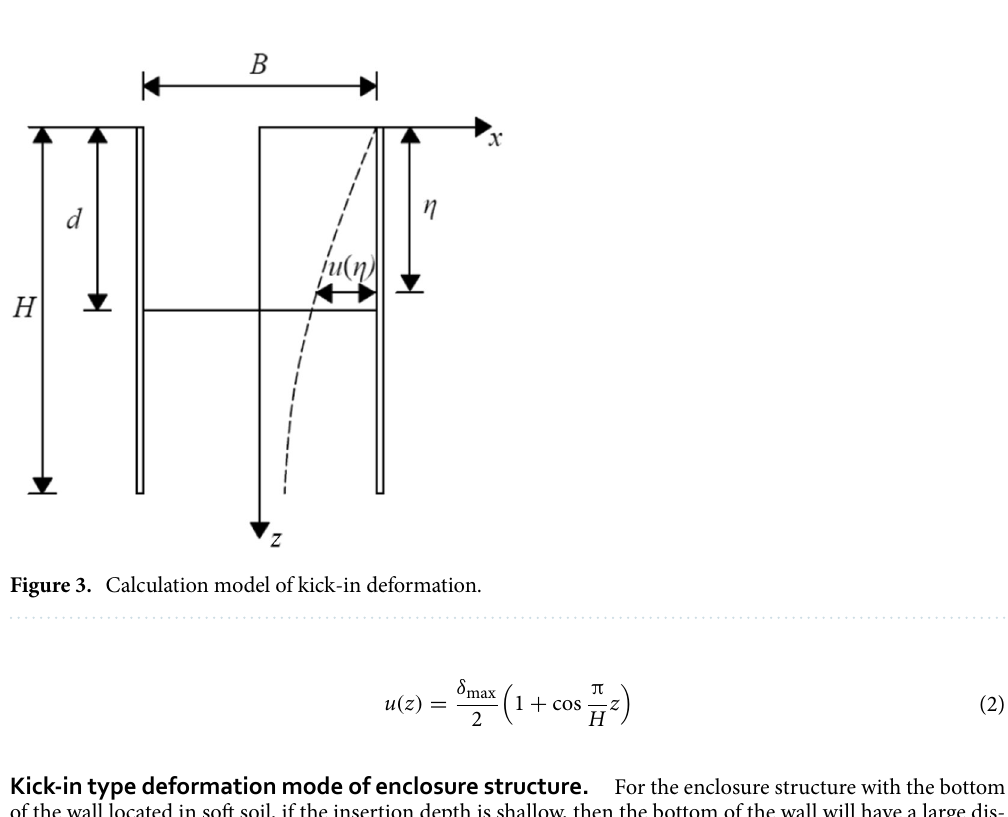
Figure 2. Calculation model of cantilever deformation.